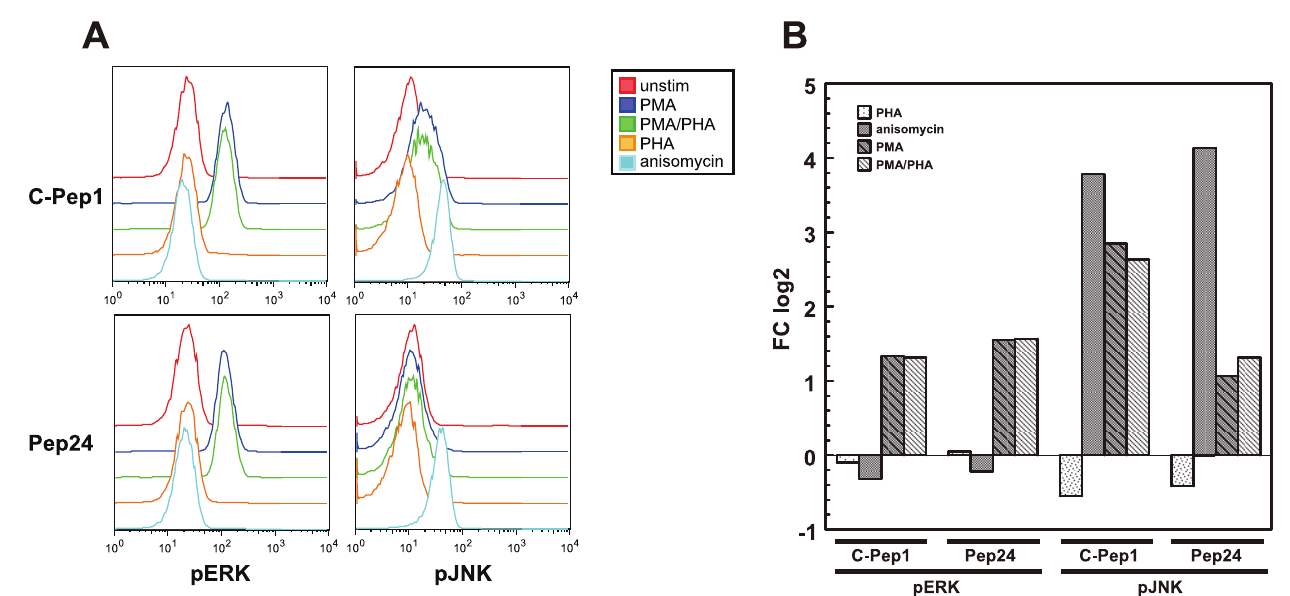
Figure 3. JNK is one of kinases on which HIV-1 depends. Jurkat cells expressing C-Pep1 or Pep24 were treated with indicated stimuli. Cells were stained with pERK-Alexa 647 or pJNK-Alexa 647 phosphospecific antibodies and analyzed by flow cytometry. (A) Histograms are colored according to the different stimuli. (B) Fold change was approximated by calculating the log2 ratio of mean fluorescence intensity of stimulated versus unstimulated cells.